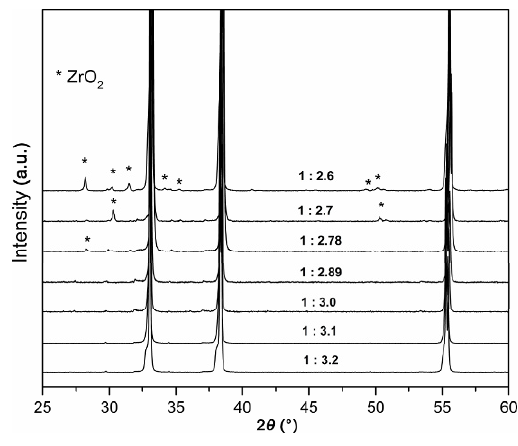
Fig. 6 XRD patterns of different powder